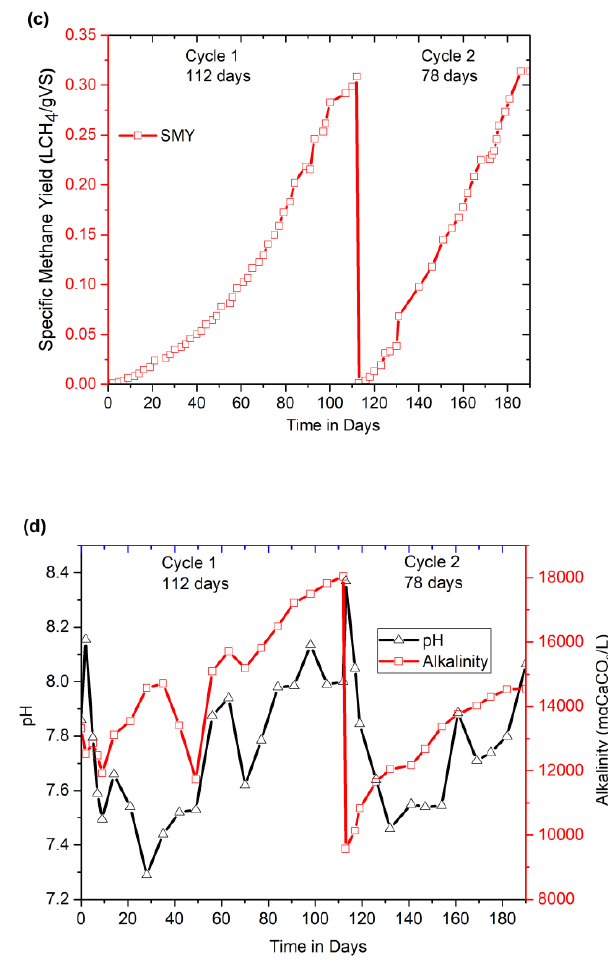
Figure 2. Performance of the liquid and solid digesters at different organic loading rates (OLRs) during 190 days of operation. ( a ) Biogas production rate; ( b ) Biogas composition; ( c ) Specific methane yield (SMY); ( d ) pH and alkalinity profiles.